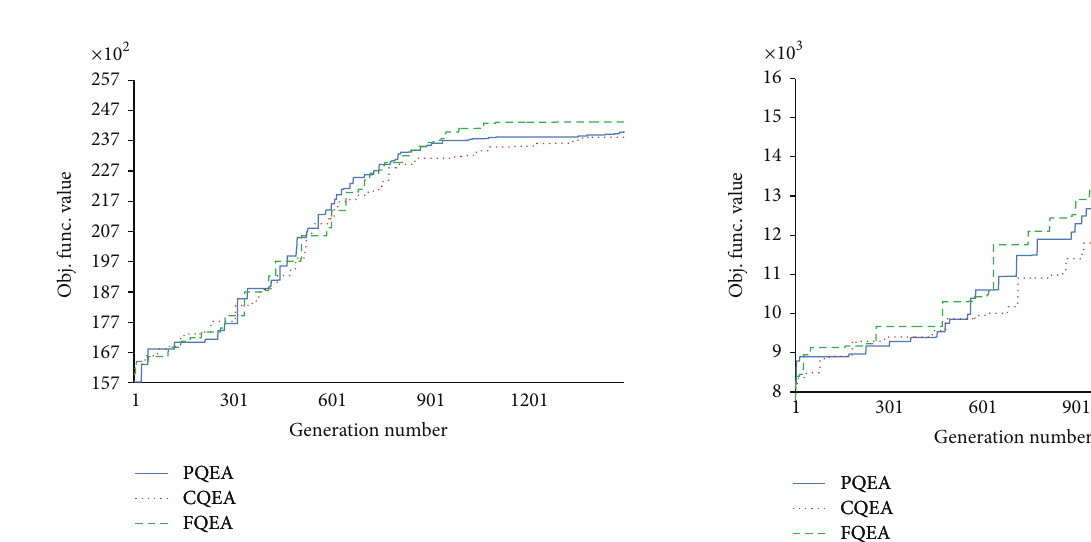
Figure 19: Convergence graph of PQEA, CQEA, and FQEA on 0-1 knapsack problem with multiple strongly correlated data instances with number of items, 𝑀 , being 200 and capacity, 𝐶 , being 10% of total weight.